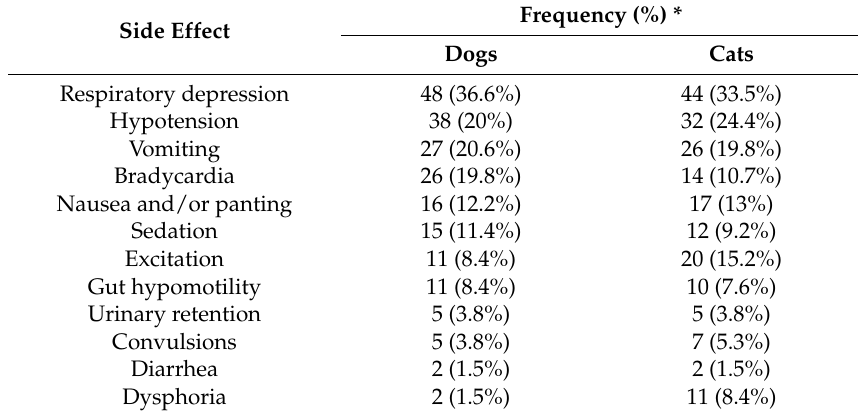
Table 3. Evaluation of adequate knowledge on side effects of opioids in 131 veterinarians in the city of Medellin,